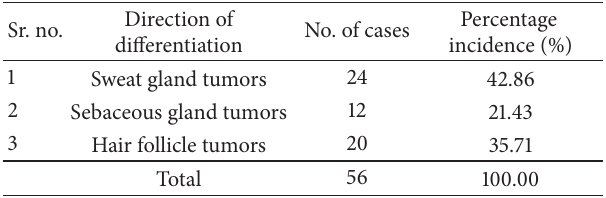
Table 1: Adnexal tumors according to the direction of differentia-